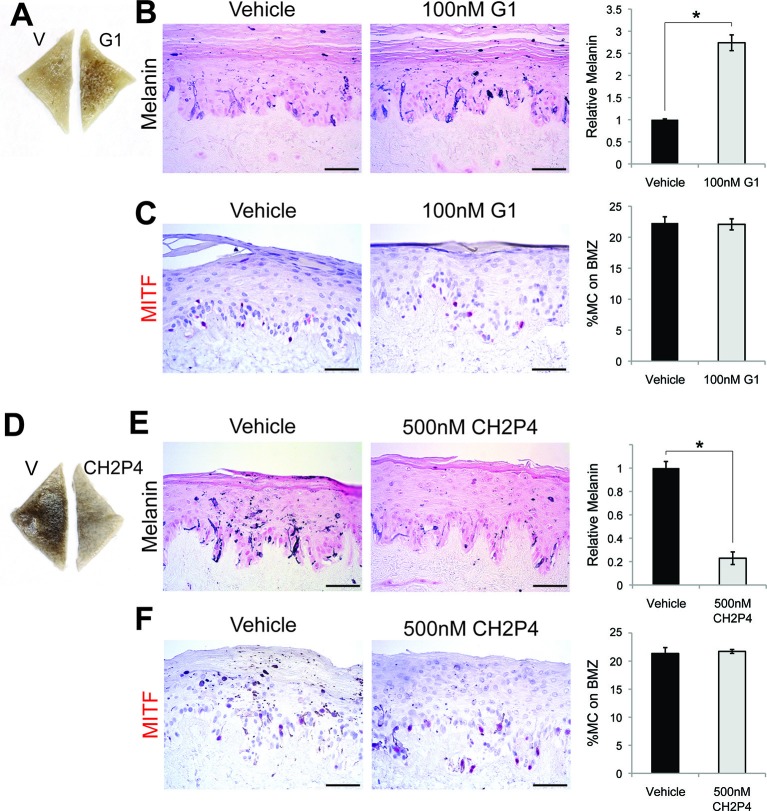
GPER and PAQR7 signaling is sufficient to alter melanin production in organotypic human tissue.(A) Organotypic skin treated with vehicle (left) or G-1 (right). (B) Fontana-Masson (melanin) staining of organotypic skin treated with vehicle or G-1. Quantification of melanin content is shown on the right. (C) MITF immunohistochemistry of organotypic skin treated with vehicle or G-1. Quantification of melanocyte population density is shown on the right. (D) Organotypic skin treated with vehicle (left) or CH2P4 (right). (E) Fontana-Masson (melanin) staining of organotypic skin treated with vehicle or CH2P4. Quantification of melanin content is shown on the right. (F) MITF immunohistochemistry of organotypic skin treated with vehicle or CH2P4. Quantification of melanocyte population density is shown on the right. n=3 biologic replicates for each experiment. Error bars denote +/- s.d., *p<0.05, scale bar = 50 μm.